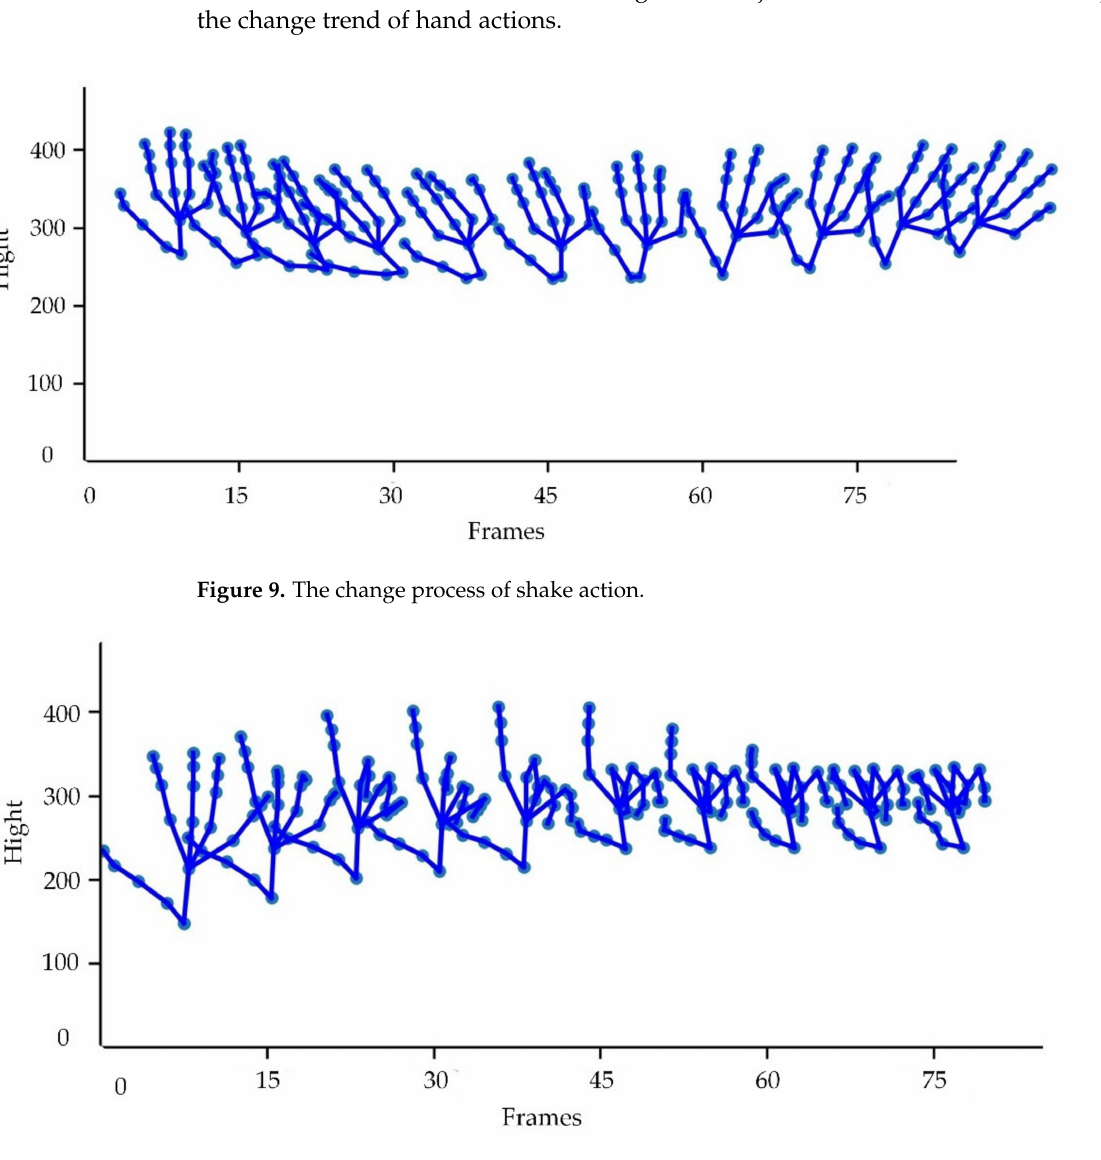
Figure 10. The changing process of grab